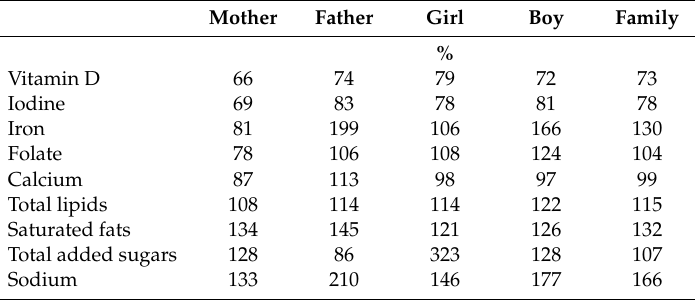
Table 6. Major relative deviations of the intake of micronutrients, fats, sodium, and added sugars from Estonian dietary guidelines by family members in the health-promoting food basket